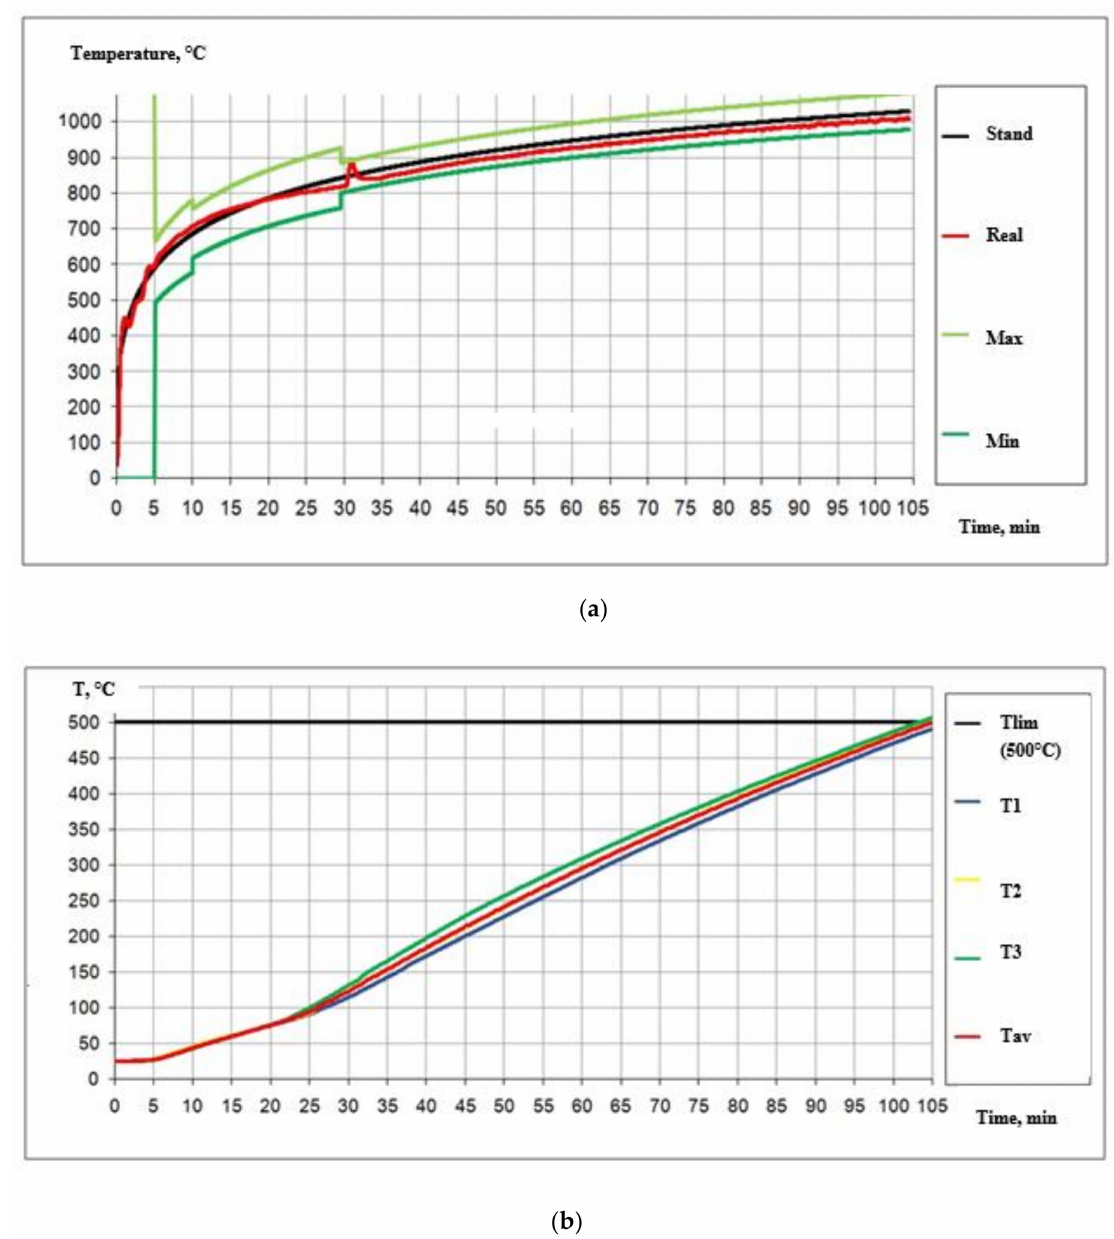
Figure 10. ( a ) Temperature regime of the test according to GOST R 53295-2009 [19]. ( b ) Structure of heating during the test according to GOST 53295-2009